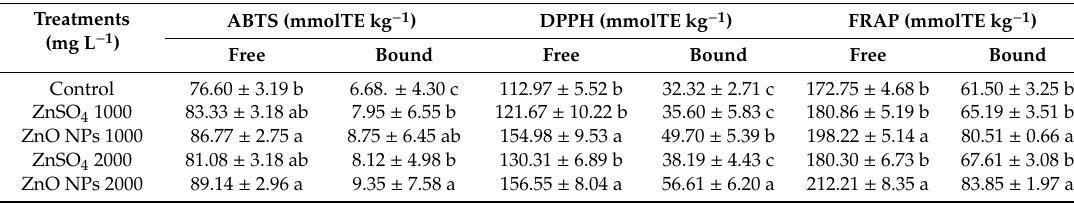
Table 5. Antioxidant activity in habanero pepper fruits obtained from plants treated with ZnO NPs and ZnSO